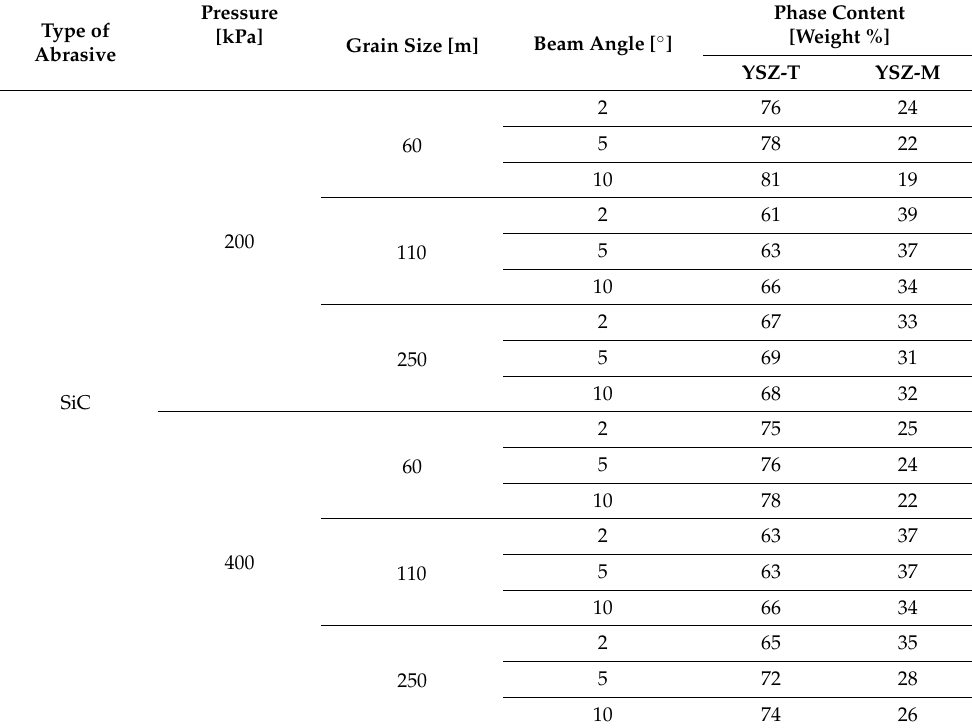
Table 3. The content of individual phases in the tested SiC